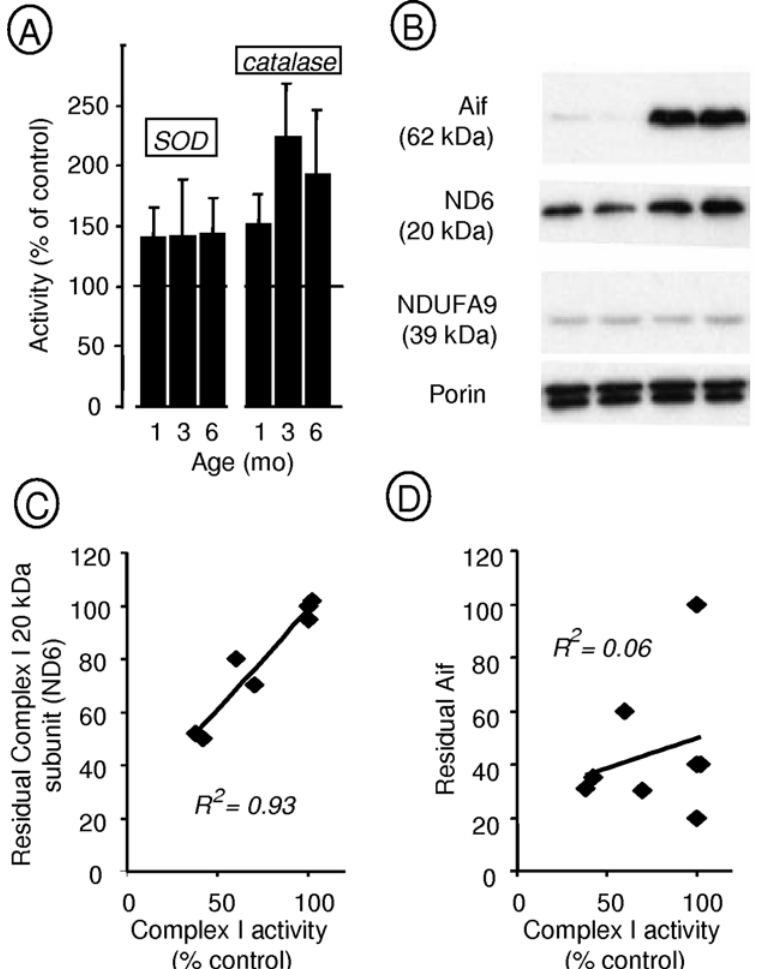
Figure 6. Antioxidant enzymes and Complex I 20 kDa subunit in various tissues of Harlequin mice. A: Superoxide dismutase (manganese- and copper, zinc-dependent SODs) activity and catalase activity measured as described in Materials and Methods in skeletal muscle tissue from Hq mice at various ages. B: Western blot analysis of Aif, complex I 20 and 39 kDa subunits (ND6 and NDUFA9, respectively) and porin in skeletal muscle of Hq mice (lines 1, 2) and control mice (3, 4). C: Plot of residual complex I 20 kDa subunit in mouse tissues against residual complex I activity, showing a significant correlation. D: Plot of residual Aif in mouse tissues against residual complex I activity, indicating no significant